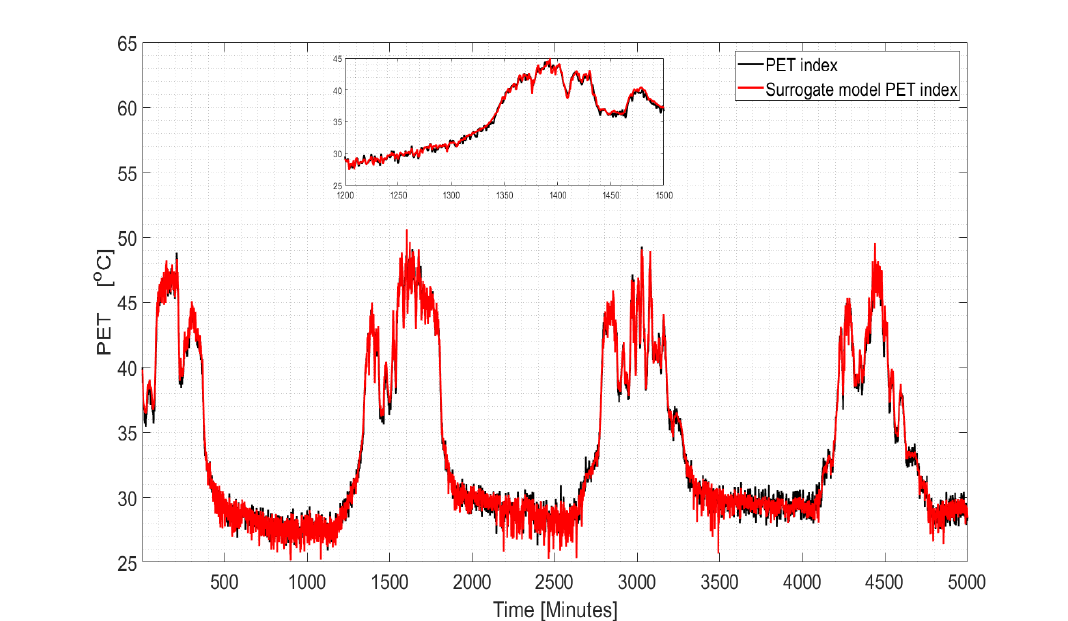
Figure 4. Comparison of time series of the true PET index values and the surrogate model of the PET index for 5000 min. The smaller figure presents a higher resolution of the comparison over 300